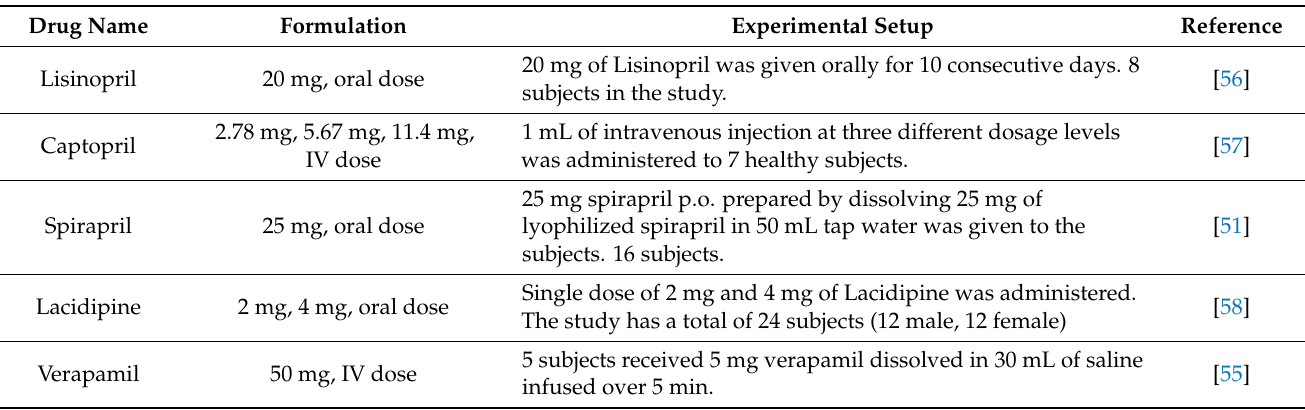
Table 3. Background on datasets used for systemic plasma-venous compartment disposition simulation and optimization of missing PK